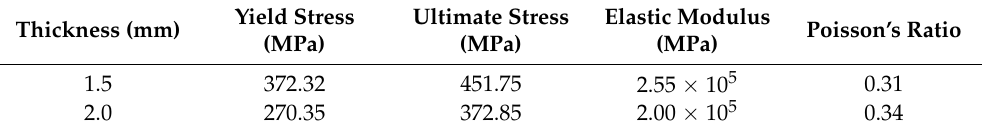
Table 2. Mechanical properties of steel.